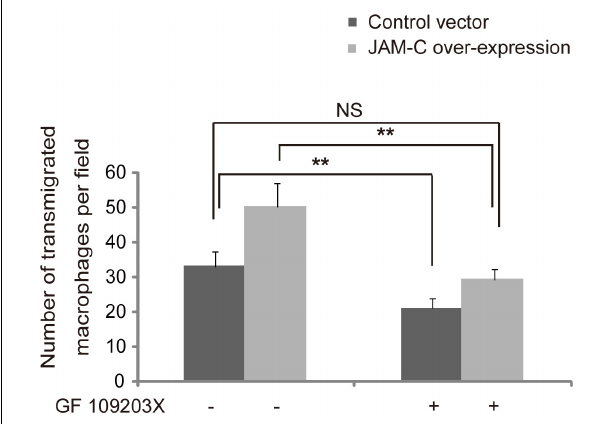
FIGURE 6 | Inhibition of PKC decreases the transmigration of macrophages from wAMD patients. An RCEC monolayer was pretreated with 1 µ M of GF109203X for 2 hr. Macrophages from wAMD patients were then added and allowed to migrate for 4 h. Transmigrated macrophages were stained with a 0.5% gentian violet for 5 min and counted in five random fields. After GF109203X treatment, macrophage transmigration decreased in both JAM-C overexpressing and control RCECs. Compared with the control group without GF109203X treatment, JAM-C overexpressing RCECs treated with GF109203X did not induce any increase in macrophage transmigration. ** P < 0.01, NS, not significant.